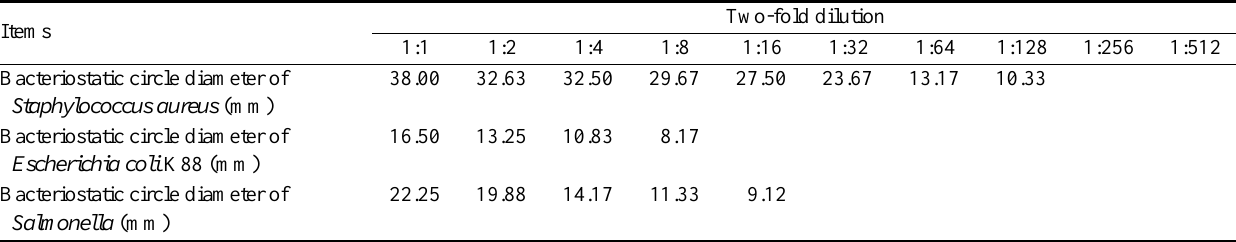
Table 2. Bacteriostatic circle diameter of Forsythia suspensa extract on the Escherichia coli K88, Staphylococcus aureus , and Salmonella 1